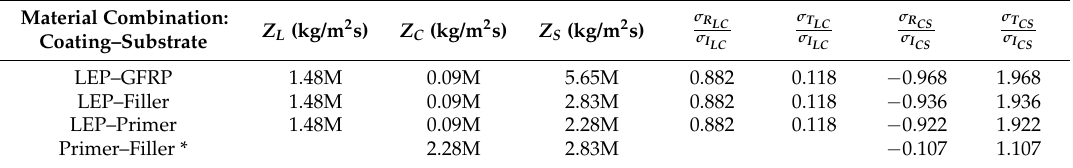
Table 5. Impedance properties of LEP candidate materials. Reflected and transmitted waves as a function of the incident stress at the surface (liquid–coating) and at the interface